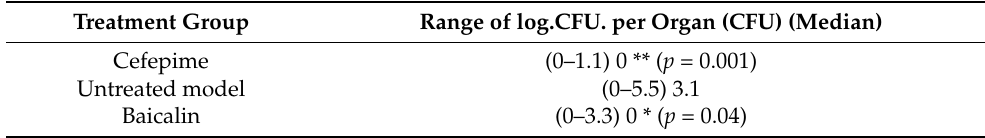
Table 2. The numbers of CFU of P. aeruginosa in rat lungs. Treatment